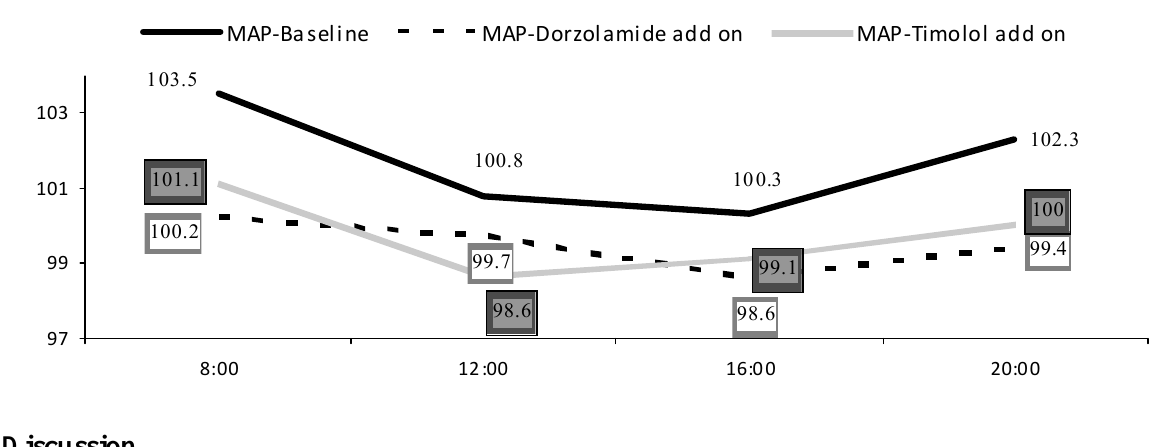
Figure 3. MAP diurnal